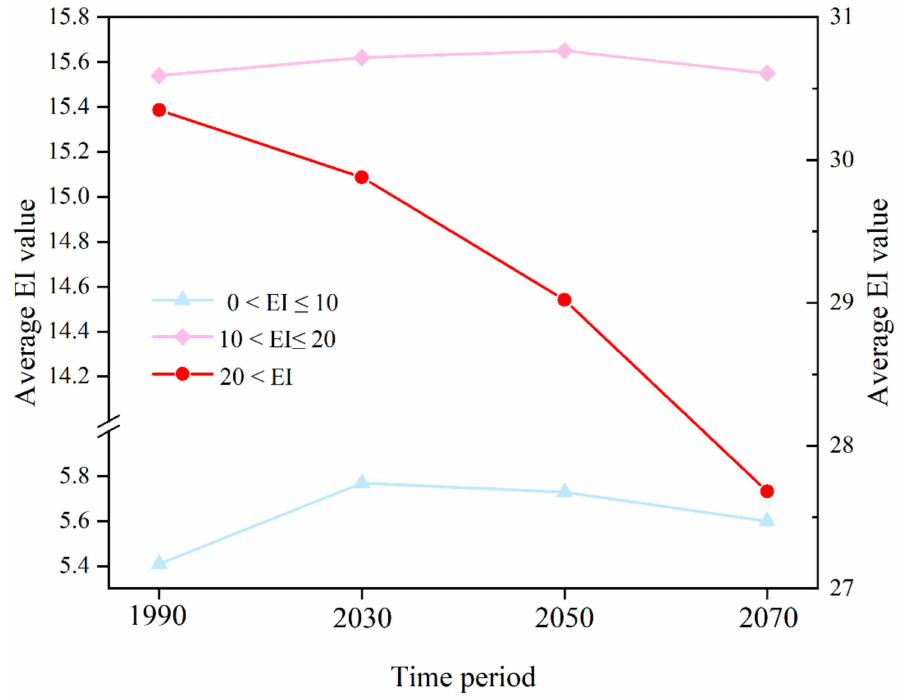
Figure 6. Average EI values of the different potential distributions of habitats under different periods. (right Y-axes: red = highly favorable habitats; upper left Y-axes: pink = favorable habitat; bottom left Y-axes: blue = marginally favorable